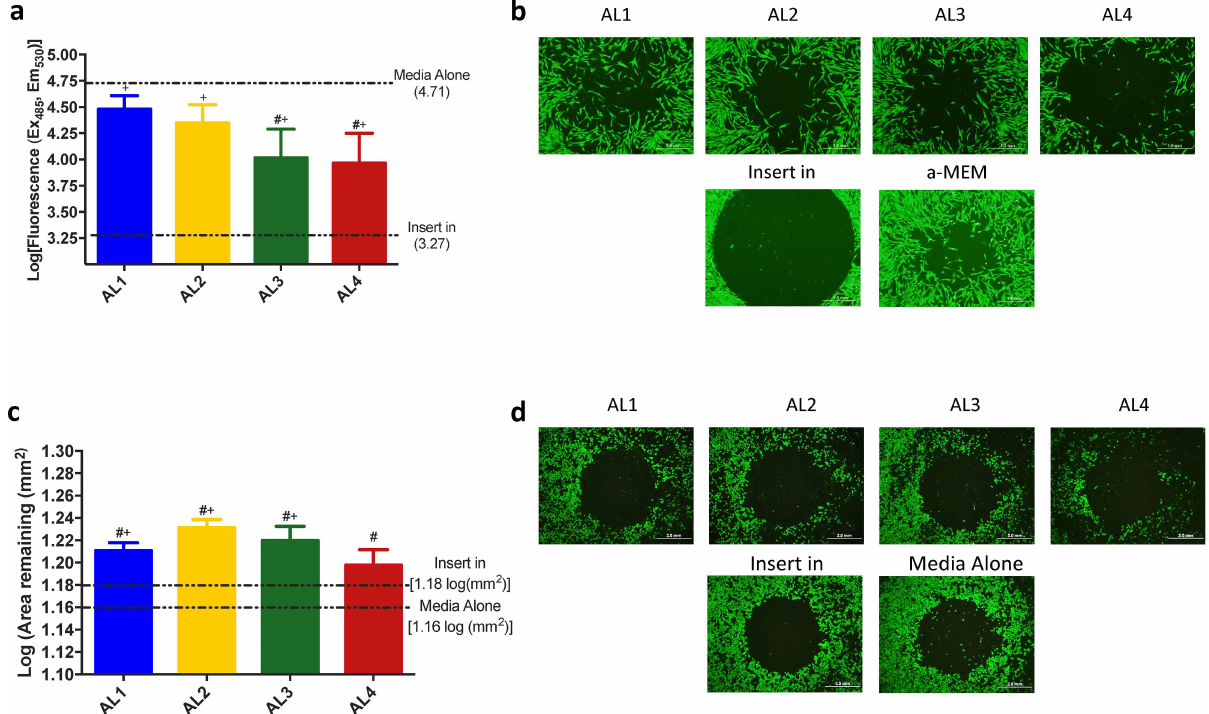
Fig 5. The effect of MEM-BTM on Fibroblast and Keratinocyte migration. (a) Fibroblasts seeded on cell migration plates were allowed to migrate overnight.Fibroblasts incubatedwith BTM from all locationsmigrated more than the negative control (p < 0.04) however migration was impeded in BTM from ventral swabs (AL3, p = 0.04 & AL4, p = 0.04) compared to a-MEM control (two-tailed unpairedt-test, n = 7/AL). #, p < 0.05 v. Media control; +, p < 0.05 v. “Insert in” Control. (b) Respective 4x images of each location are shown and scale bars represent 1.0 mm. (c) Keratinocytes seeded on cell migration plates were allowedto migrate overnight. NHEKs incubatedwith BTM from all locations exhibitedretraction compared to media control (p < 0.05), however AL1 (p = 0.004), AL2 (p = 0.0003), and AL3 (p = 0.02) also exhibitedsignificant retraction compared to negative control (two tailed unpairedt-test, n = 7/AL). #, p < 0.05 v. Media control; +, p < 0.05 v. Insert In Control. (d) Respective 2x images of each location are shown and scale bars represent 2.0 mm. Images are a representation of two independent